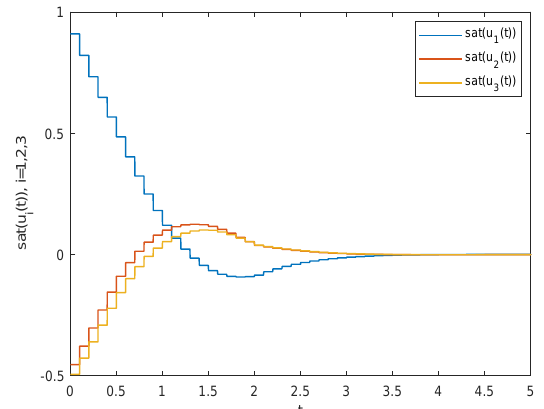
Figure 3. Schematic of the saturated aperiodic sampled-data (SD) controller sat ( u ( t )) of Example I.